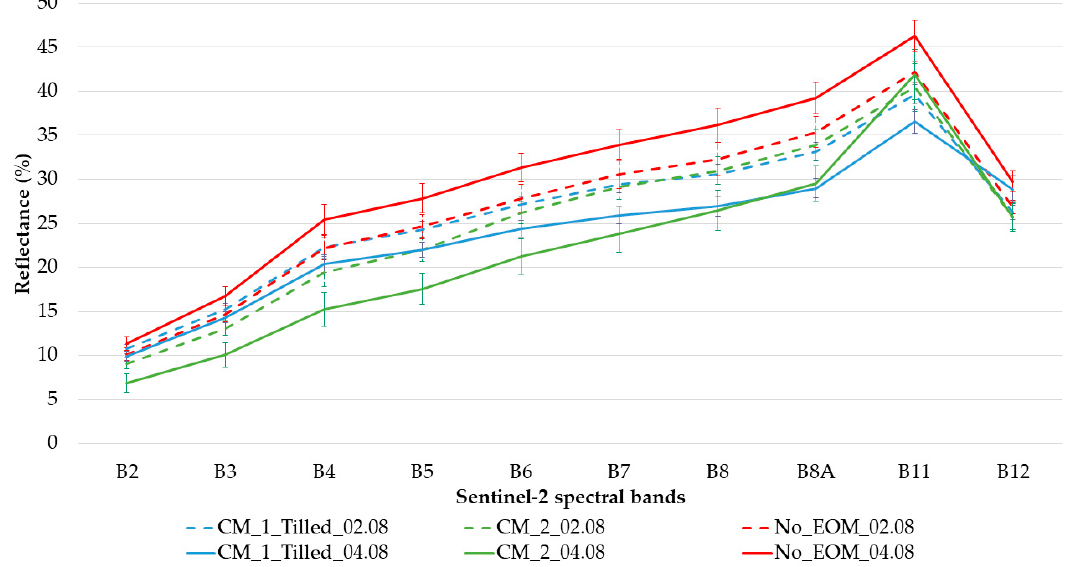
Figure 4. Mean reflectance of sample fields before (2 August) and after (4 August) cattle manure amendment of beginning of August 2018. Both CM_1_Tilled and CM_2 received EOM, but the farmer also tilled and sowed a cover crop on the CM_1_Tilled .